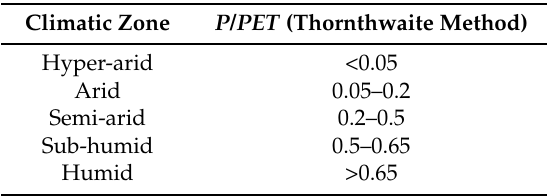
Table 1. Classification limits of the Aridity Index according to the UNEP